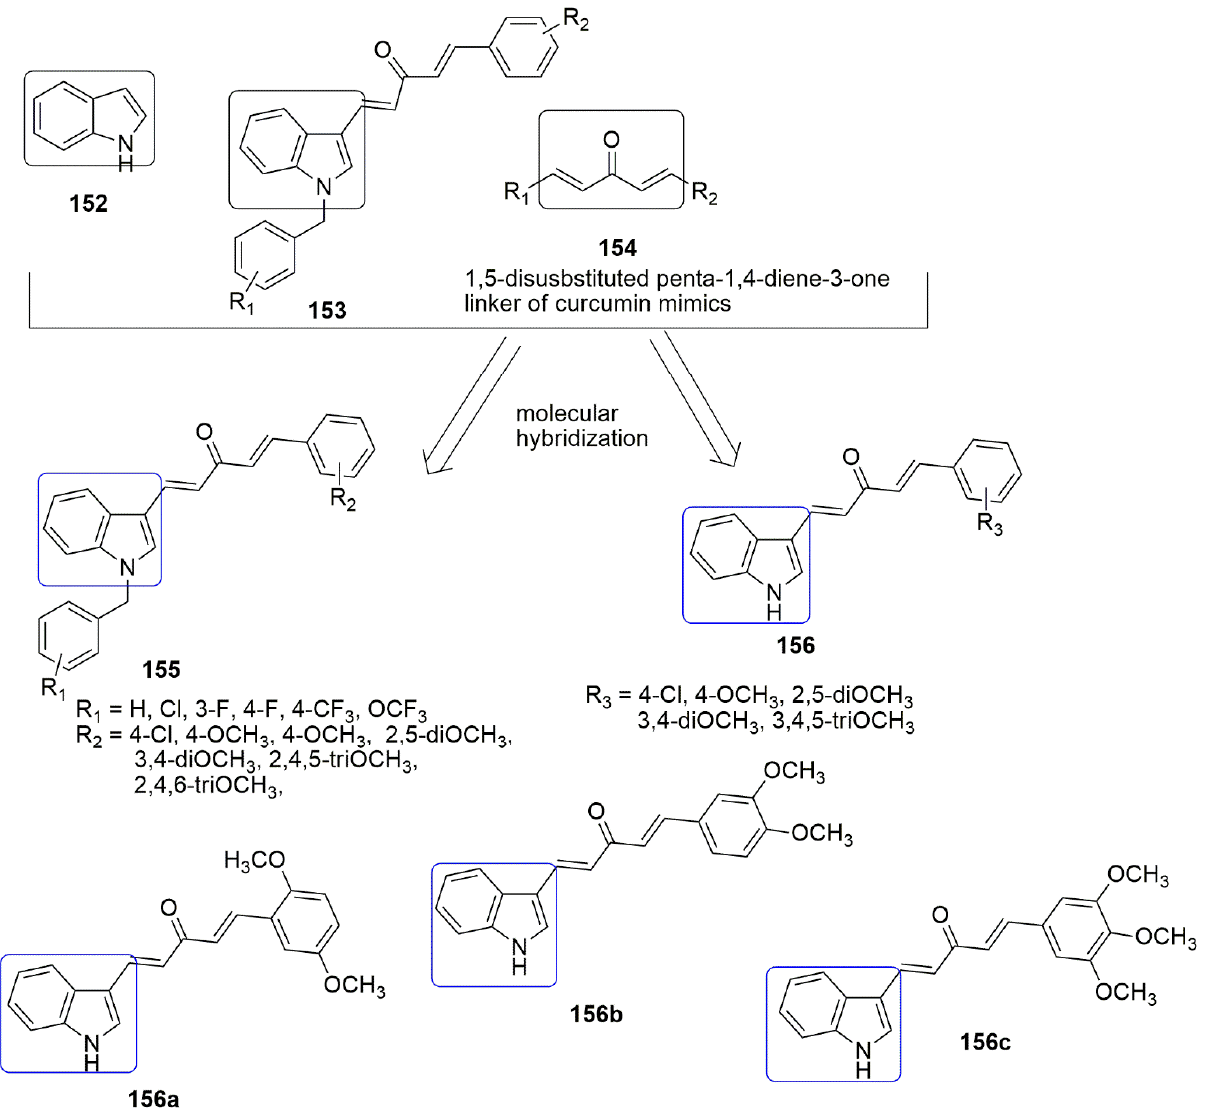
Figure 41. Chemical structure of curcumin-indole analogs evaluated against different panel cancer cell lines.